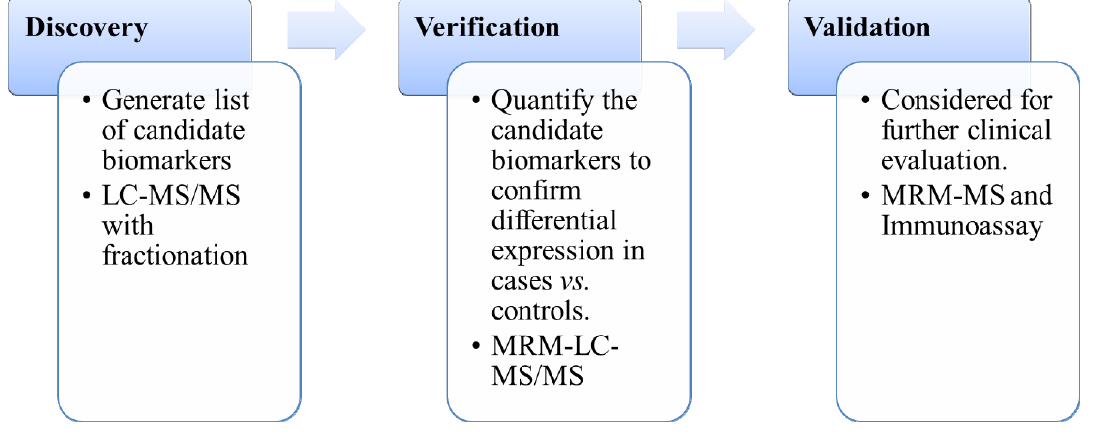
Figure 1. Categorization of the biomarker development. LC-MS/MS, liquid chromatography tandem mass spectrometry. MRM-LC-MS/MS: multiple reaction monitoring-liquid chromatography tandem mass spectrometry. MRM-MS: multiple reaction monitoring-mass